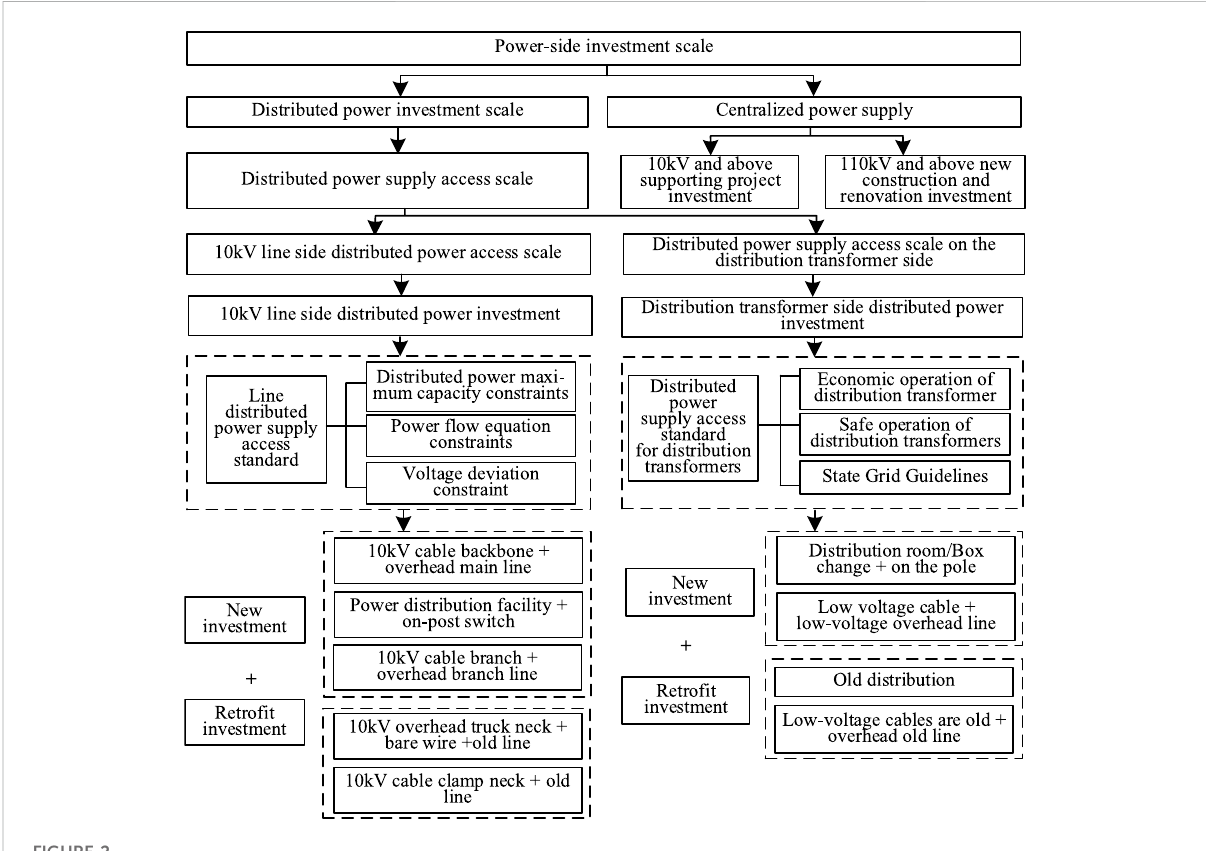
FIGURE 2 Flow chart of investment scale calculation of power supply side in future